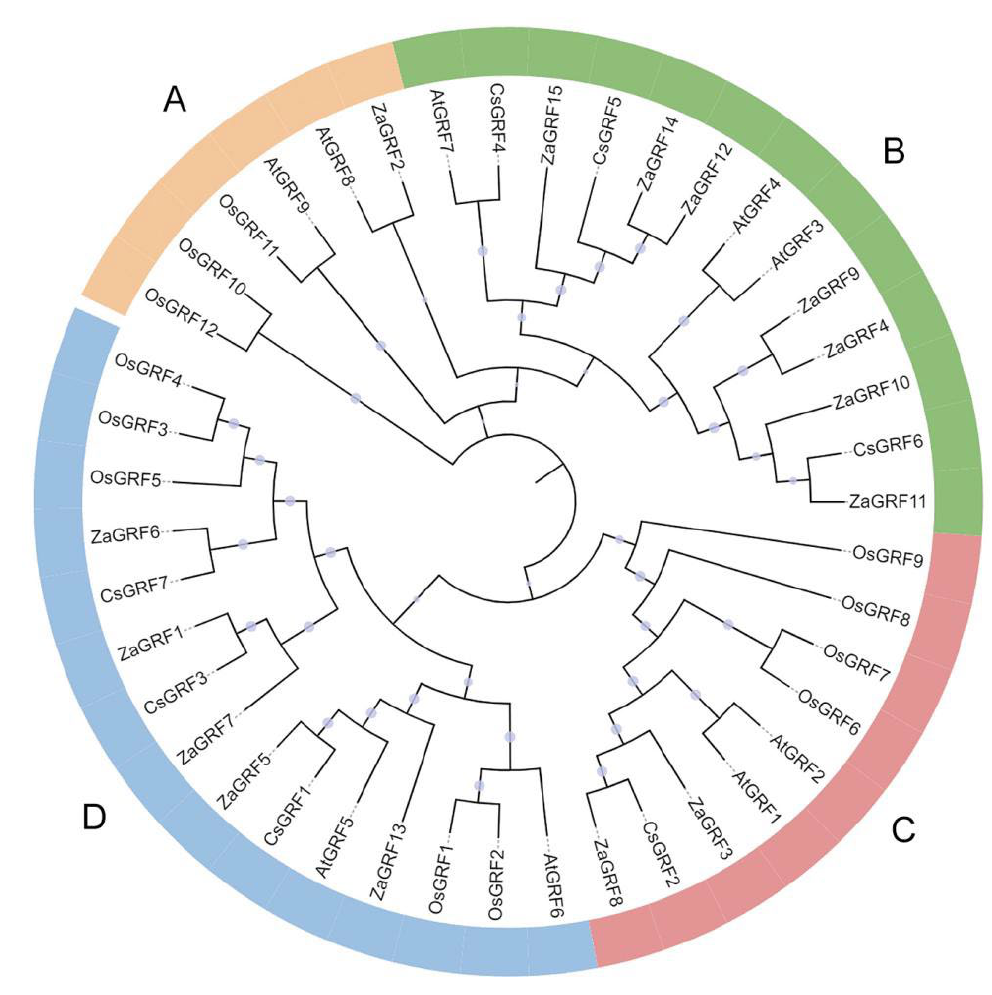
Figure 4. Phylogenetic relationship of ZaGRF proteins along with proteins of three other species. The start of each sequence contained codes for the following species: Za: Zanthoxylum armatum , Cs: Citrus sinensis , At: Arabidopsis thaliana , Os: Oryza sativa.